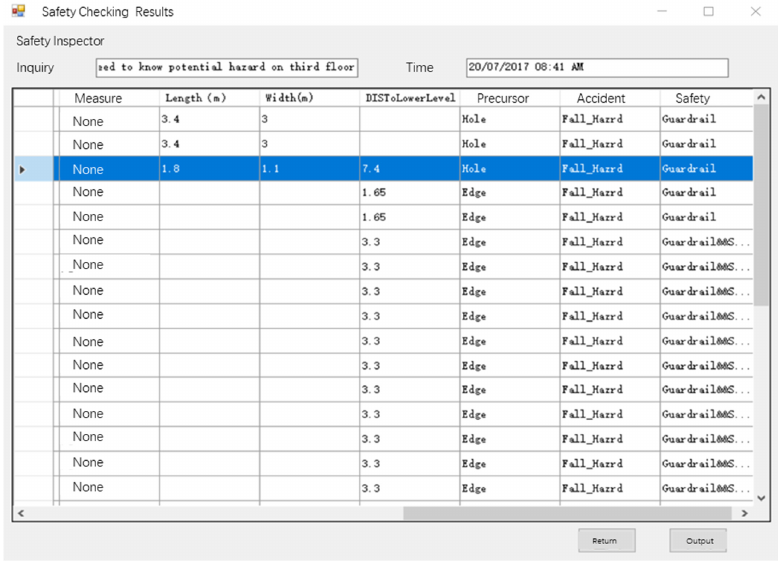
Figure 24. Safety risk query result and the suggested safety measures.